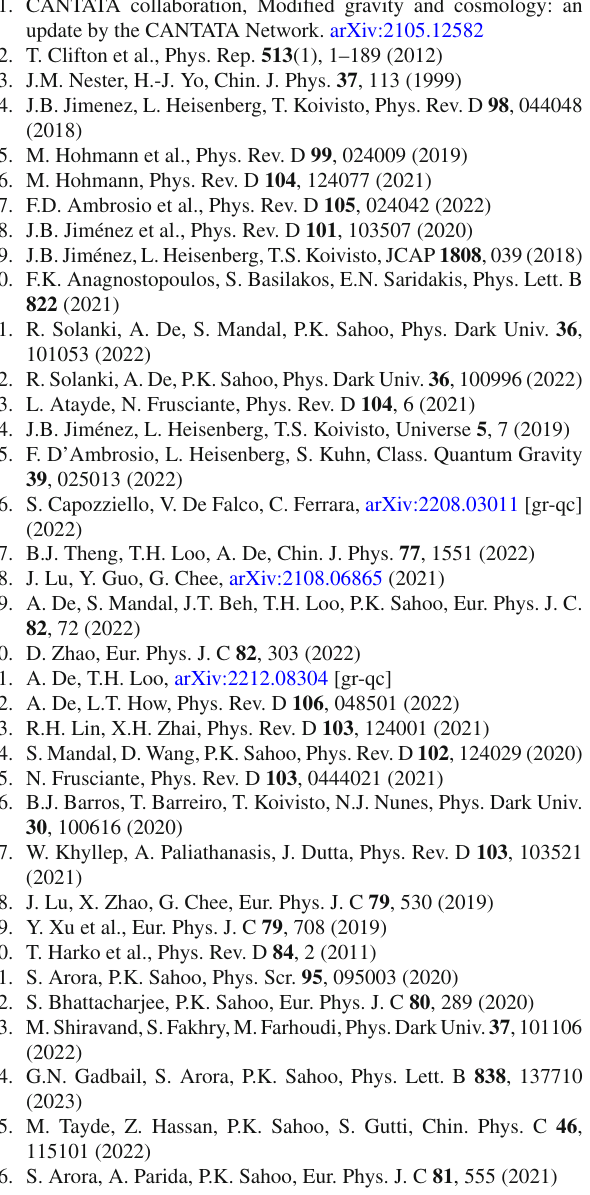
energy momentum scalar term T i.e., for the case β =